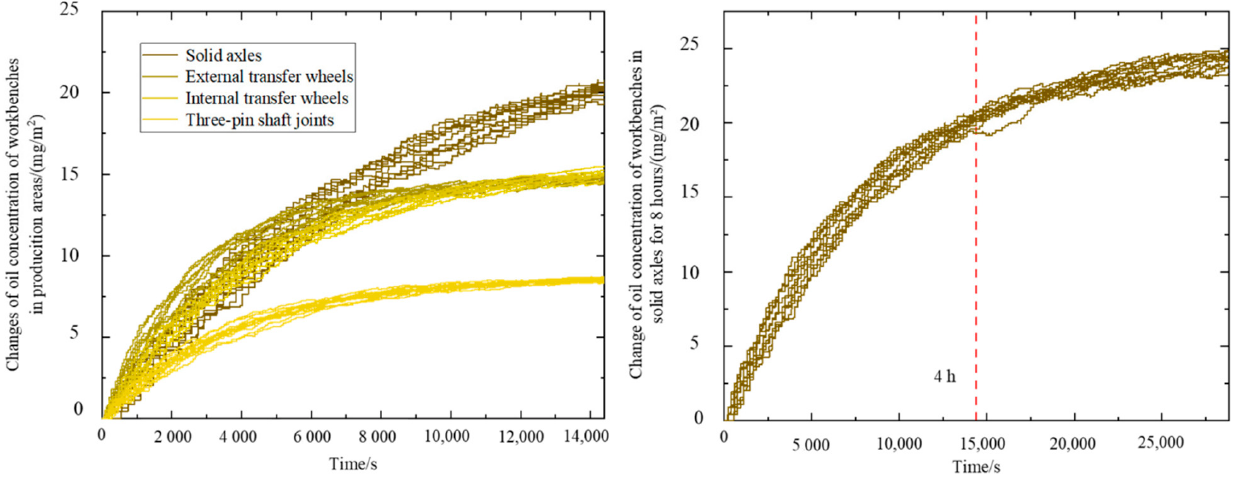
Figure 5. Changes in oil concentrations of the workbenches.